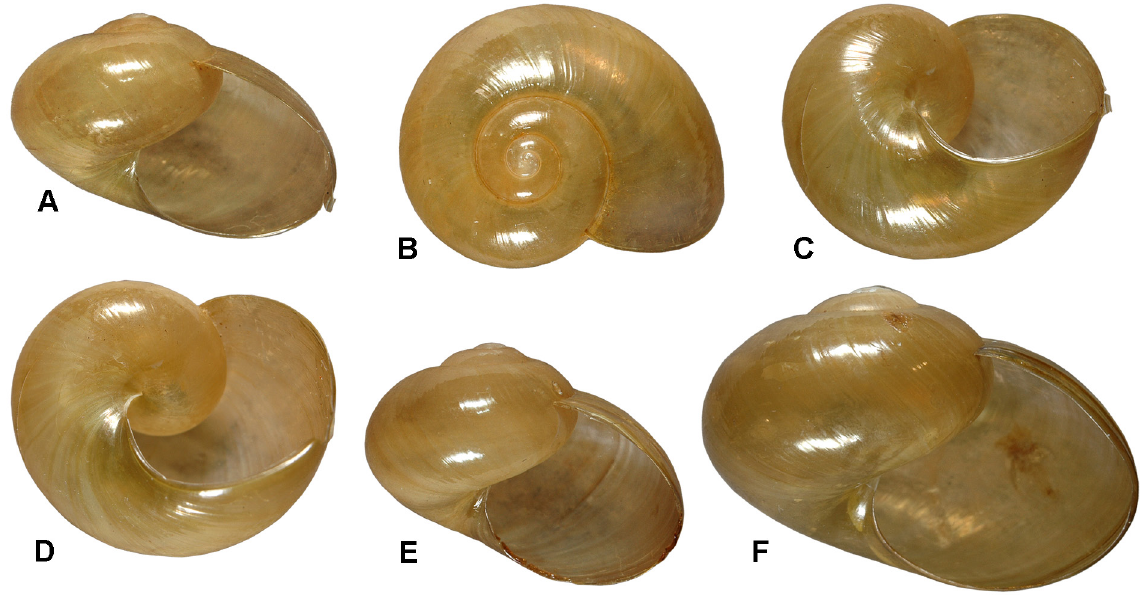
Fig. 9. Sheldonia monsmaripi sp. nov. A–D . Holotype, diameter 12.2 mm (NMSA W4413/T3300). E . Paratype, diameter 12.0 mm (NMSA W3900/T3172). F . Large specimen from fynbos on Mariepskop summit, diameter 16.4 mm (NMSA